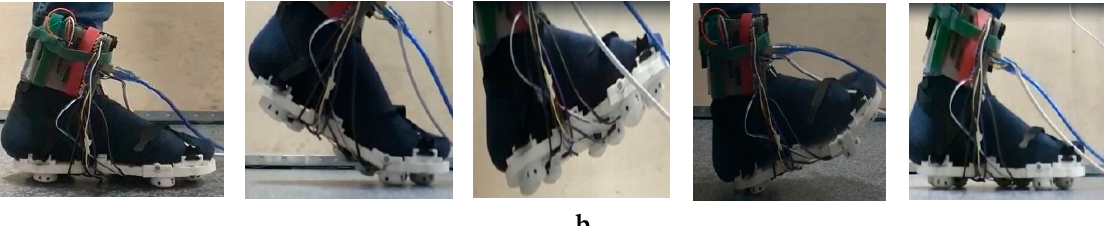
Figure 5. ( a ) Distribution of pressure sensors on the sole; ( b ) one ‐ legged stepping cycle.